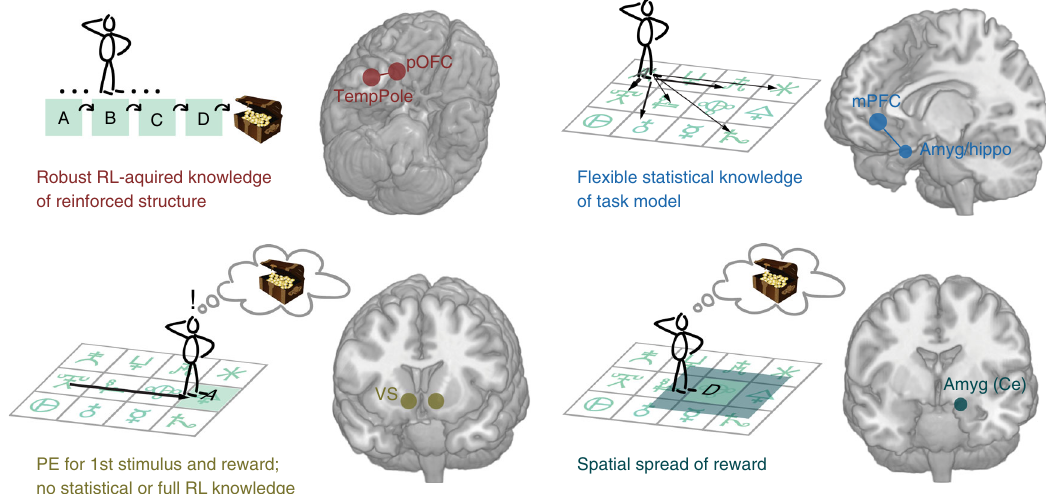
Fig. 7 Schematic summary. Schematic overview of the key fi ndings of this study. Note that this schematic focusses on the differences in the neural representations we identi fi ed. All four regions spanning the medial and lateral networks shown in the top row also showed BOLD signatures that suggested knowledge of undirected relationships within the rewarded compared to the control sequence (sequence fusion, Fig. Fig. 5; Fig. 7), a region with strong dopaminergic innervation 65